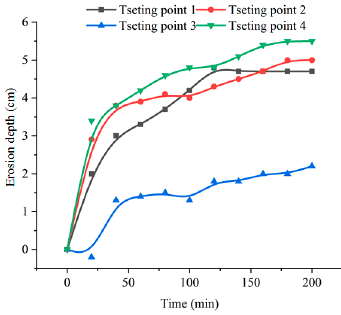
Figure 18. The development of scouring effect versus time at different positions before using fishnet.